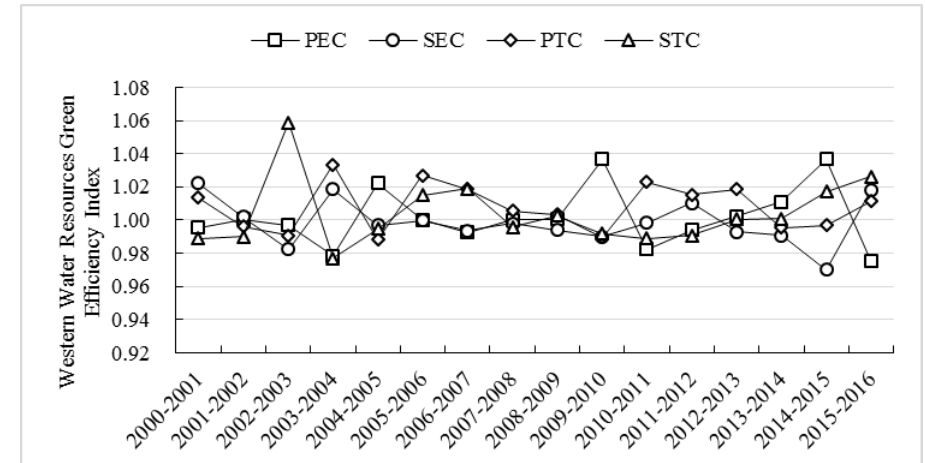
Figure 6. Changes in the components of water resources green efficiency in the western region of China during the study period 2000–2016 (PEC = pure technical efficiency change, SEC = scale efficiency change, PTC = pure technology change and STC = scale technology change).